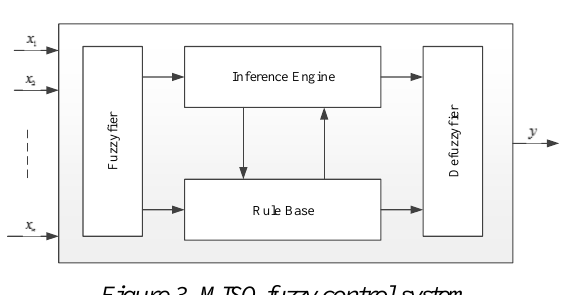
Figure 3. MISO fuzzy control